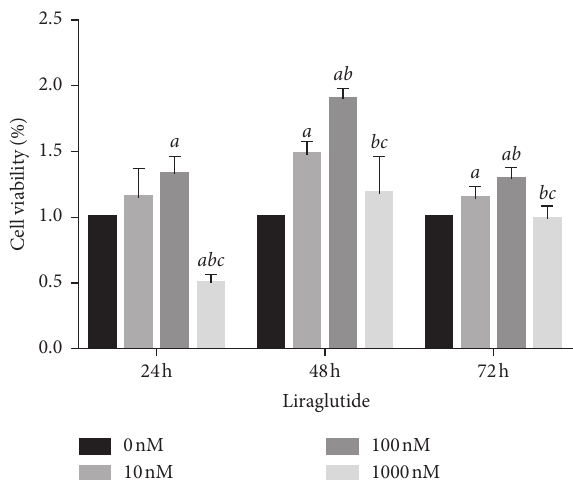
Figure 1: Effects of liraglutide on the viability of MC3T3-E1 cells. The cells were treated with liraglutide at different concentrations for 24, 48, and, 72h, and the cell viability was assessed by using CCK-8 assay. aP < 0.01 compared with 0nM, bP < 0.01 compared with 10 nM, and cP < 0.01 compared with 100nM.